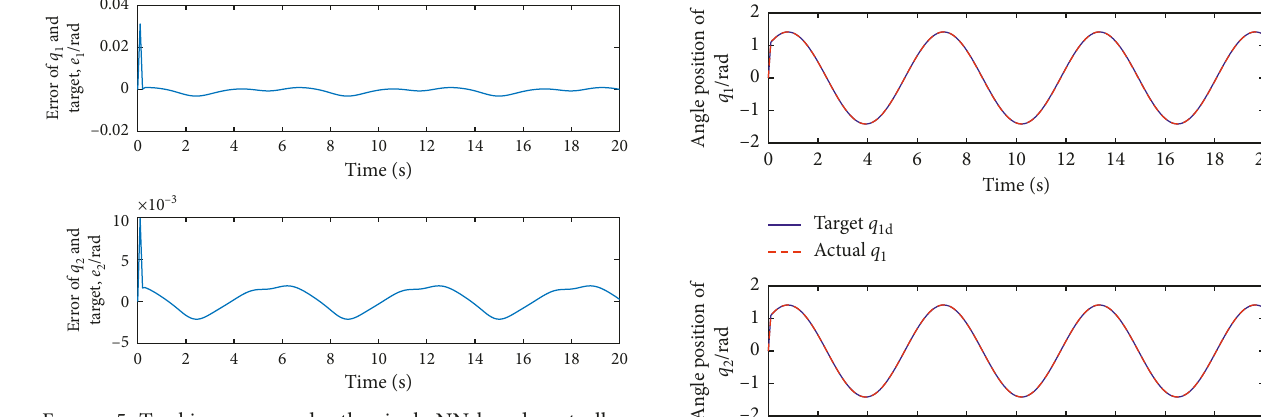
Figure 5: Tracking error under the single NN-based controller.